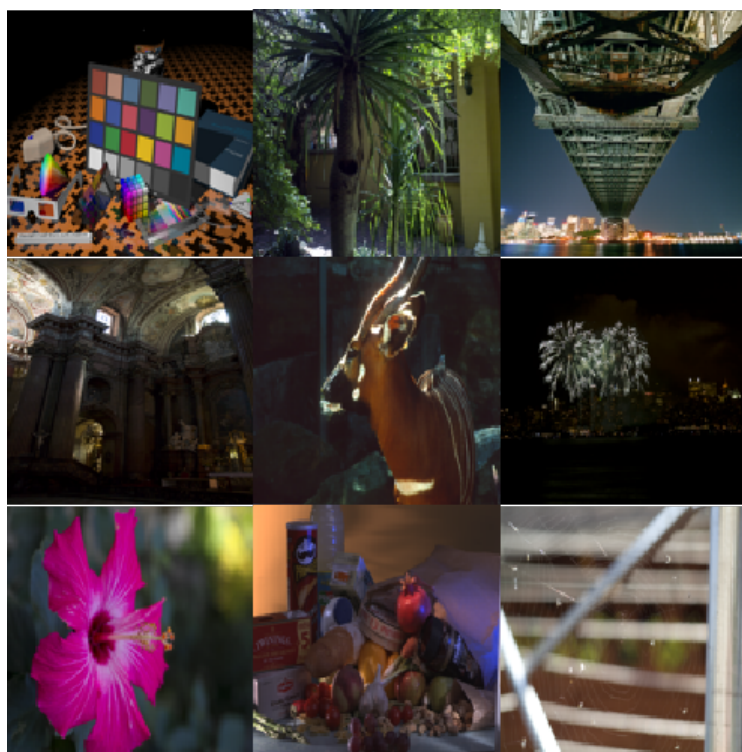
Figure 23. Examples of 16-bit RGB